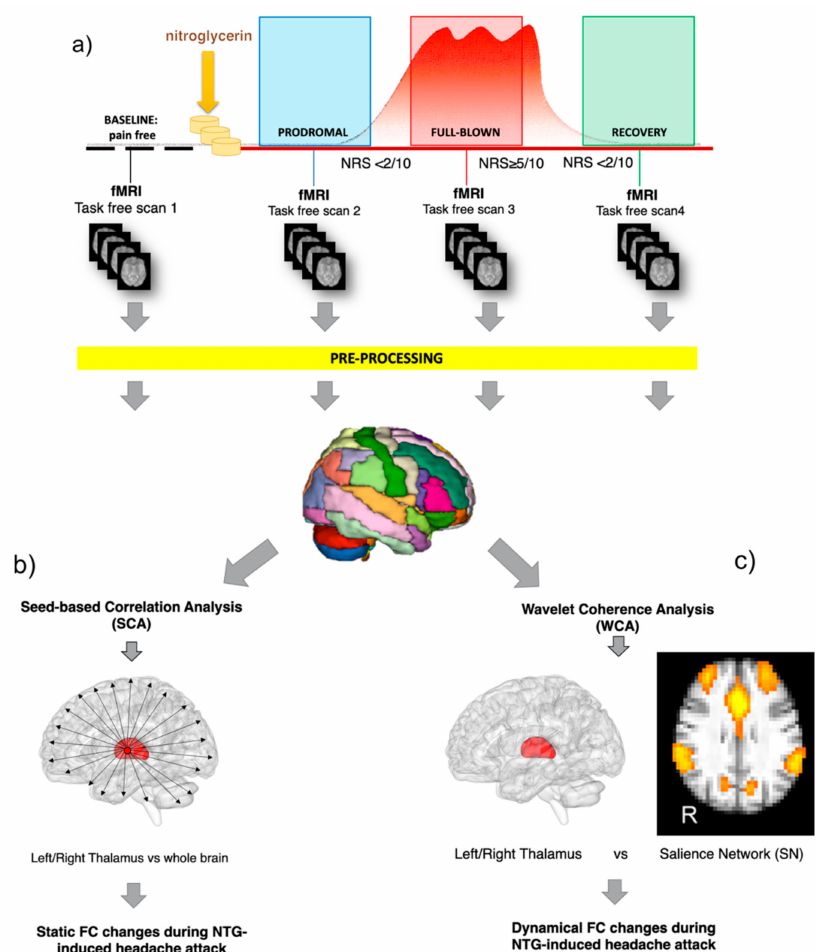
Figure 1. Workflow of the study. ( a ) Each subject underwent four fMRI scans in a day, matched with the different attack phases (baseline at a pain-free condition, prodromal, full blown, recovery) before and after the nitroglycerin (NTG) administration. fMRI data were first pre-processed and then treated with two different methodological approaches: ( b ) seed-based correlation analysis (SCA) and ( c ) the wavelet coherence analysis (WCA). SCA was applied on fMRI to assess the static functional connectivity (FC) changes between the thalamus and the rest of the brain. WCA was applied to test the time varying phase-coherence (dynamic) changes between the thalamus and the salience network